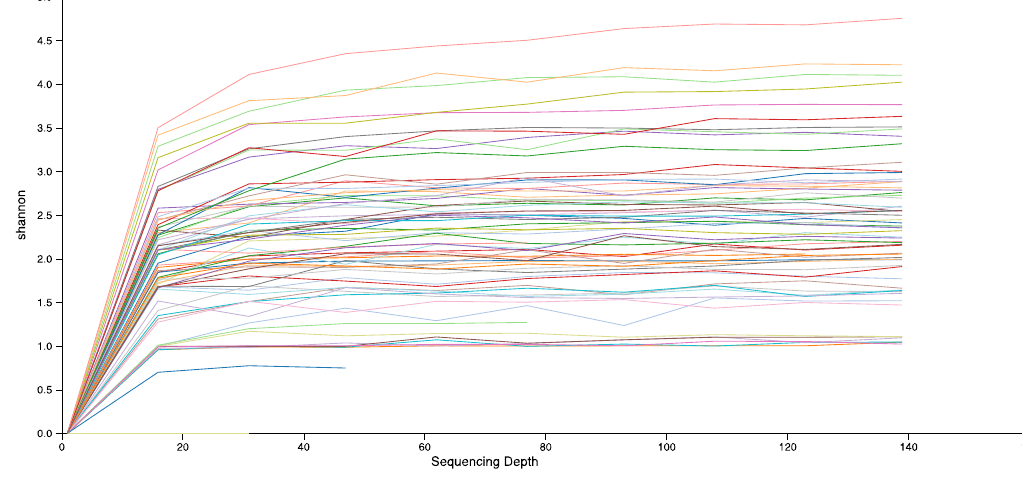
Figure 2. Rarefaction curve of Shannon diversity for the 16S reads for each sample to a read depth of 139 reads. Based on the dataset with the Sodalis reads removed.